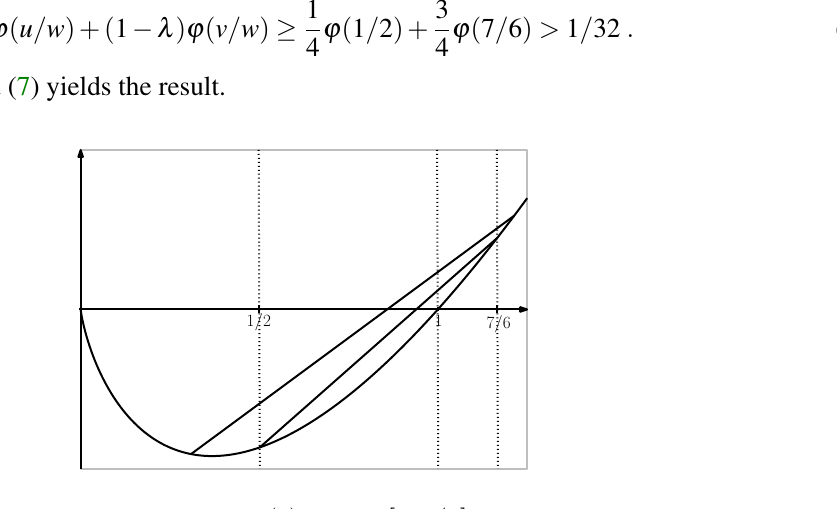
Figure 1: ϕ ( x ) for x ∈ [ 0 , 5 / 4 ]